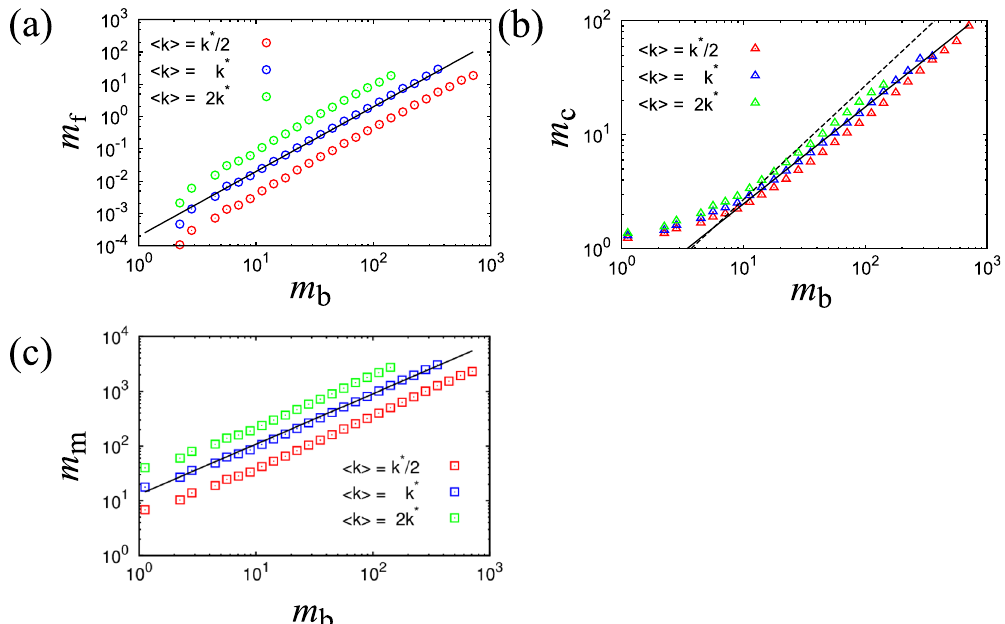
Figure 5. Scaling relationships for Erdős-Rényi networks. ( a ) The number of bone links m b vs, the number of fat links m f by cluster in log-log scale. Plots are averaged using log scaled bins over 1,000 trials. The guideline shows the power law with a scaling exponent of 2.0. ( b ) The number of bone links m b vs, the number of cartilage links m c by cluster in log-log scale. Plots are averaged using log scaled bins over 1,000 trials. The guideline shows the power law with a scaling exponent of 0.85. The dotted line shows a slope of 1.0 for reference. ( c ) The number of bone links m b vs, the number of muscle links m m by cluster in log-log scale. Plots are averaged using log scaled bins over 1,000 trials. The guideline shows the power law with a scaling exponent of